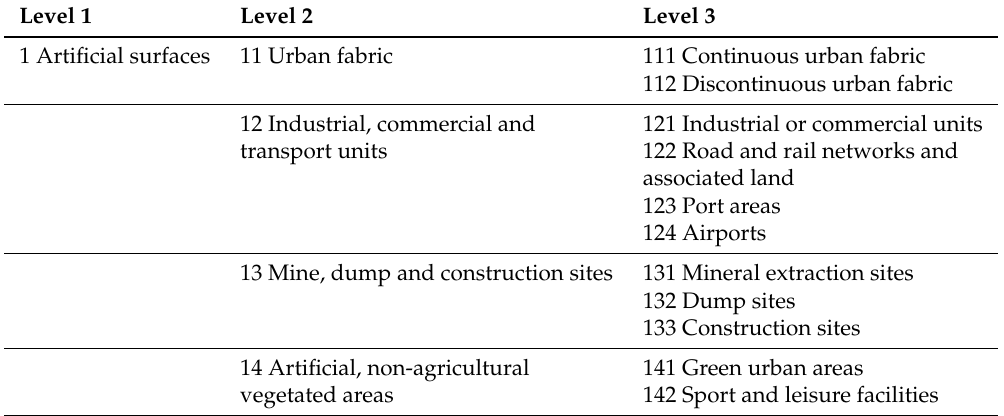
Table 2. Classes of anthropogenic areas with codes according to CORINE Land Cover.